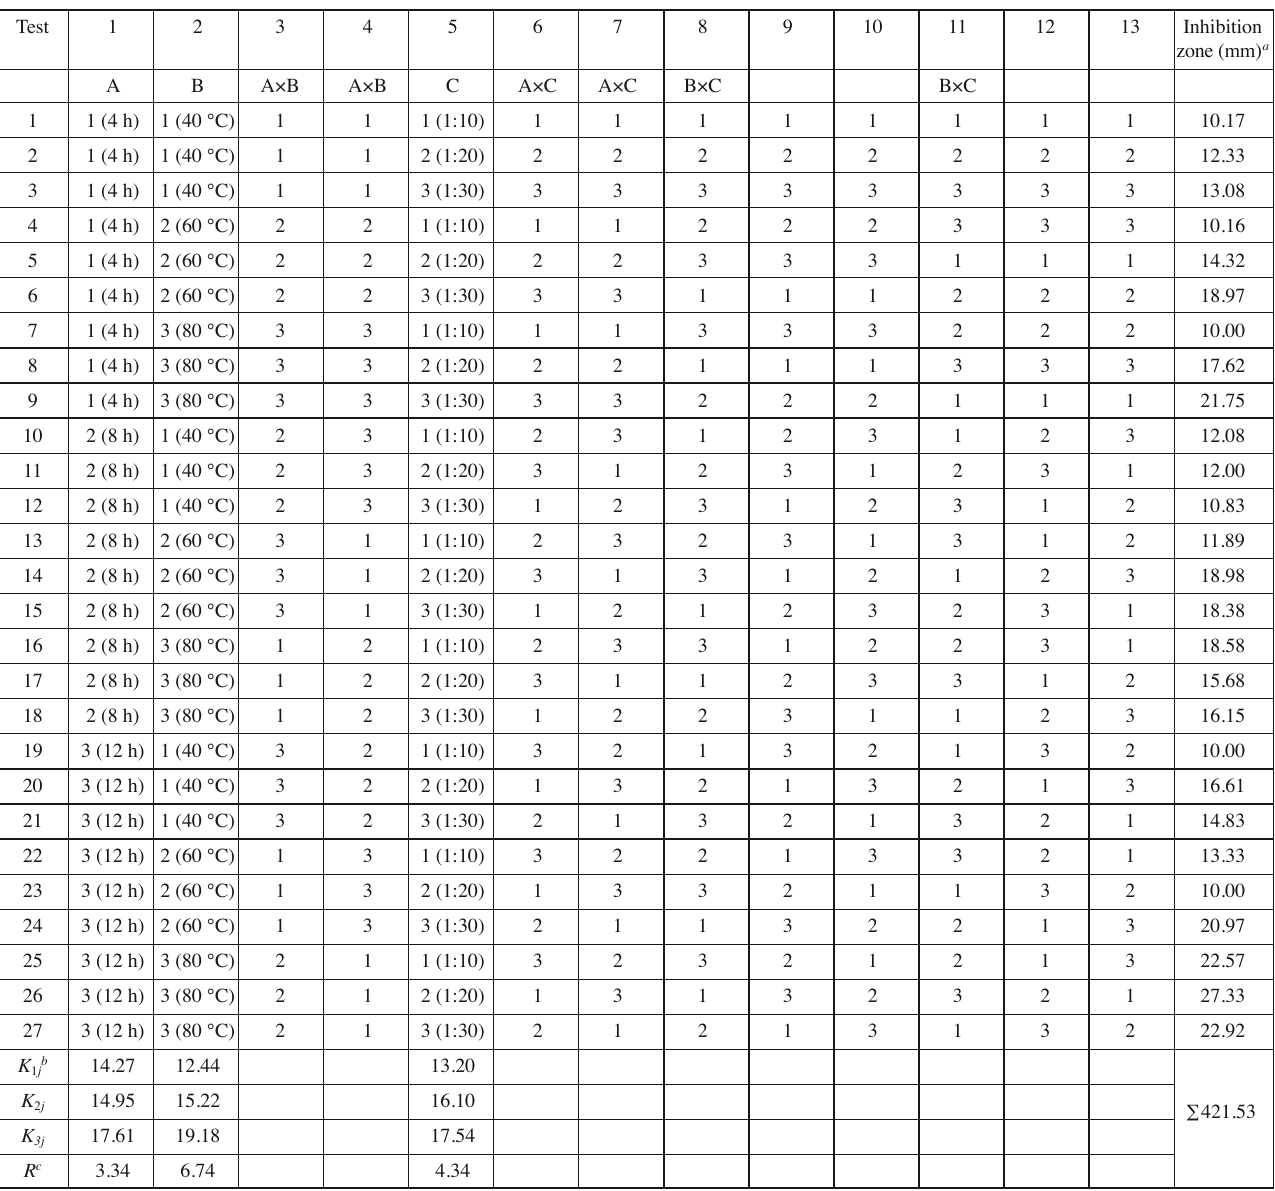
Tab. 2: Intuitive analysis of orthogonal array